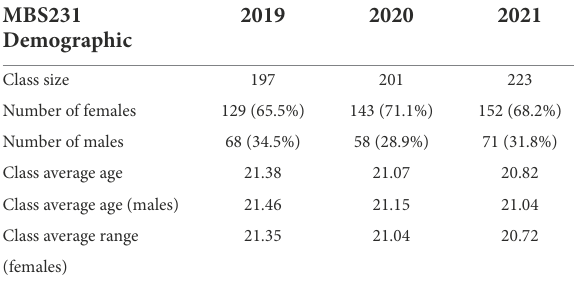
TABLE 1 Demographical data of 2019, 2020, and 2021 student groups. MBS231